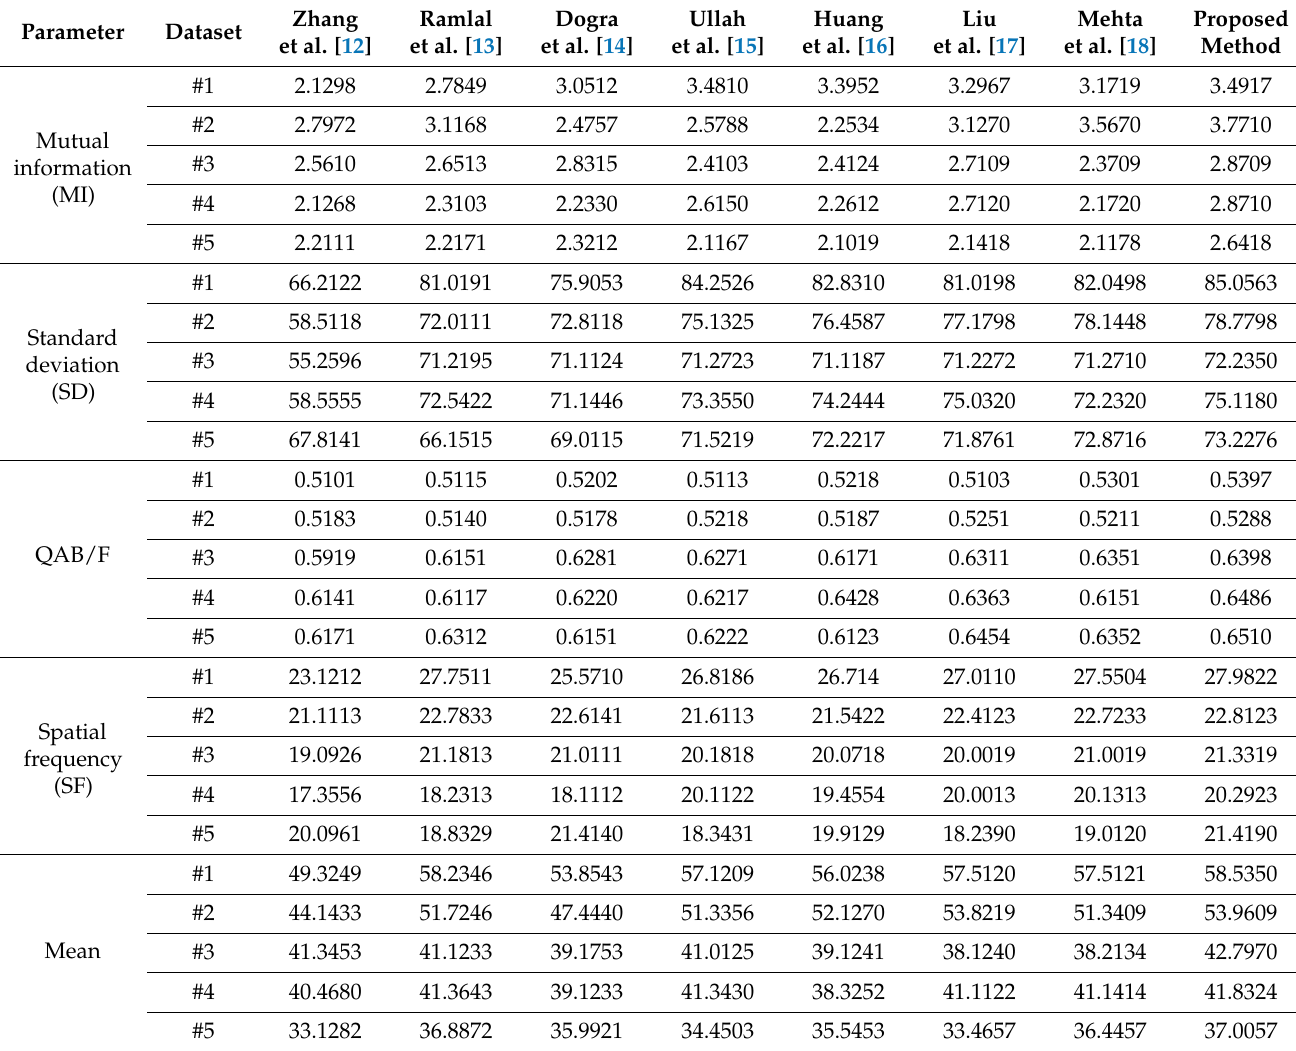
Table 1. The Comparative analysis in terms of performance